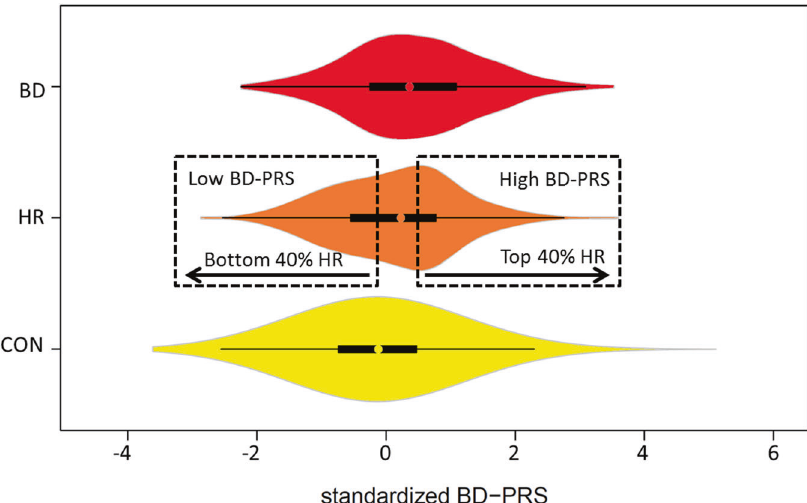
Fig. 2 Violin plot of BD-PRS by clinical group in European-ancestry individuals. BD-PRS was standardised using the mean and standard deviation of all participants with genotype data (including an independent sample of BD cases and controls) regardless of availability of methylation data ( n = 1699 controls, 354 HR, 355 BD; M = 0.0077695, SD = 7.543 × 10 − 5 ). The boxes and whiskers inside the violins indicate the 25 – 75th percentiles, and 1.5 times the interquartile range, respectively. The dashed rectangles indicate the strati fi cation of HR participants into High-BD-PRS vs. Low-BD-PRS strata, as de fi ned by the top and bottom two quintiles (i.e. 40% of the HR distribution), for the epigenome- wide association study. HR high risk, BD bipolar disorder, CON control, PRS polygenic risk